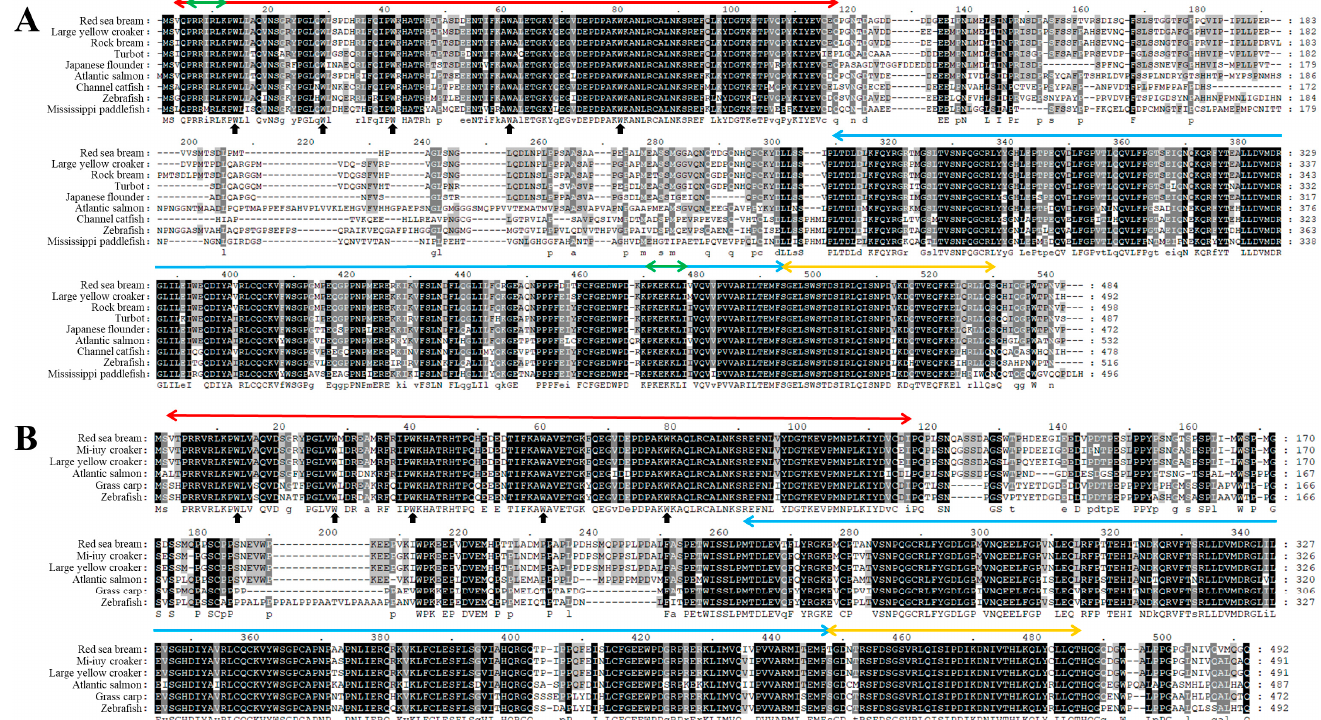
Figure 1. Multiple sequence alignment analysis of the ( A ) IRF5 - and ( B ) IRF6 -derived amino acid sequences in various fish species. Red double-headed arrows at the N-termini indicate the DNA binding domain (DBD), with five conserved tryptophan residues indicated by black arrows. The blue double-headed arrows at the C-termini indicate the IRF association domain (IAD), while the viral-activated domain (VAD) is indicated by the yellow double-headed arrows. The nuclear localization signals (NLSs) are indicated by green double-headed arrows.